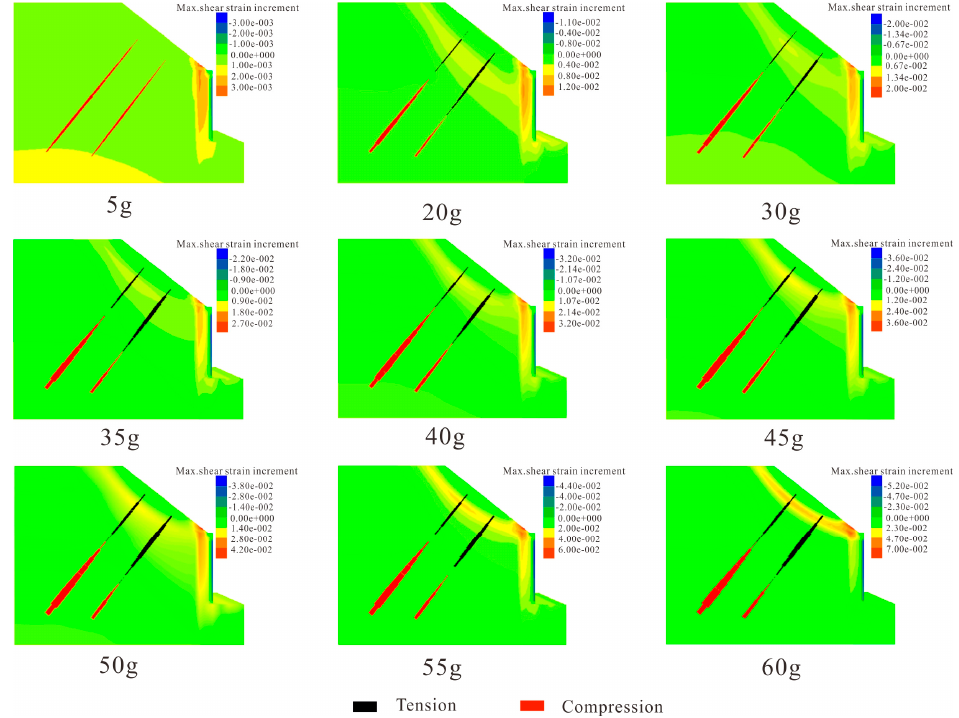
Figure 12. The simulated evaluation process of the model slope under different centrifugal force.